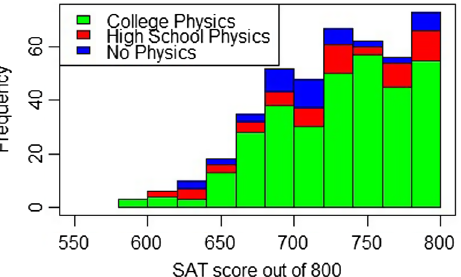
FIG. 2. Histogram of SAT math scores for students with no prior physics background (blue, N ¼ 45 ), high school physics (red, N ¼ 57 ), and AP or college physics (green, N ¼ 328 ). Scores are combination of reported SAT scores and ACT scores converted to SAT scores using concordance